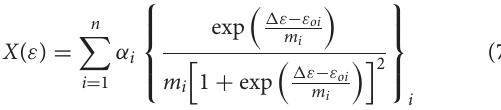
Frontiers in Chemistry |